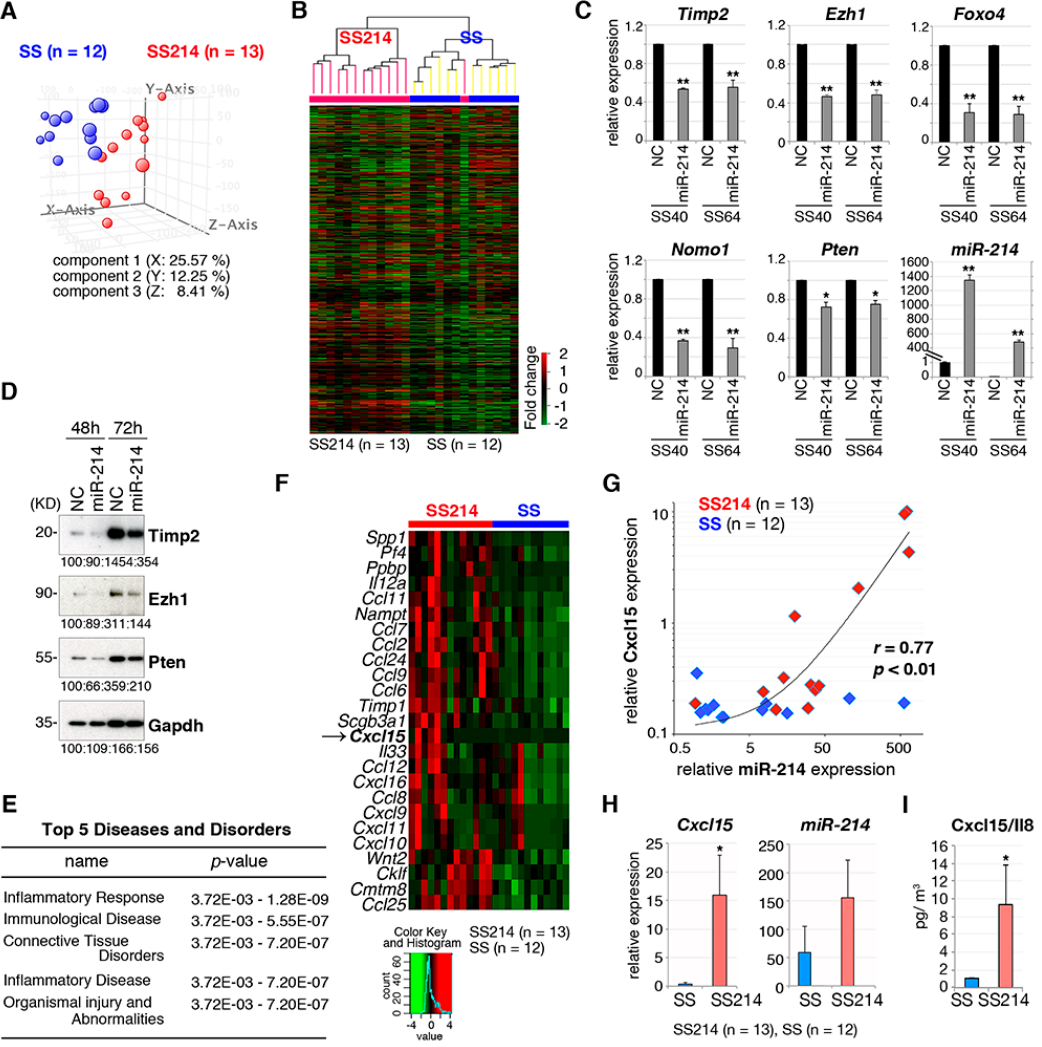
Figure 5. miR-214 expression modulates gene expression in mouse synovial sarcoma. ( A ) Principal component analysis and ( B ) Hierarchical clustering of gene expression profiles of synovial sarcoma with and without miR-214 overexpression. ( C ) RT-qPCR for candidate miR-214 target genes, Timp2 , Ezh1 , Foxo4 , Nomo1 , and Pten in synovial sarcoma cells with or without miR-214 . * p < 0.05, ** p < 0.01. ( D ) Immunoblotting for Timp2, Ezh1, and PTEN in the SS40 mouse synovial sarcoma cell with or without miR-214 introduction. ( E ) Ingenuity Pathway Analysis (IPA) of signaling pathways for 272 upregulated genes in synovial sarcoma expressing miR-214 . The key diseases and disorders are listed according to their ranking scores. ( F ) A heatmap of top 25 cytokine genes upregulated in synovial sarcoma with miR-214 expression. The arrow indicates Cxcl15. ( G ) Pearson’s correlation analysis shows positive correlation between miR-214 and Cxcl15 expression in mouse synovial sarcomas. ( H ) Quantitative RT-PCR showed Cxcl15 upregulation in miR214 -positive synovial sarcomas. Expression of miR-214 is shown in the right panel. Cxcl15 expression relative to Gapdh and miR-214 relative to sno202 are shown. ( I ) IL-8 protein expression is compared between mouse synovial sarcomas with and without miR-214